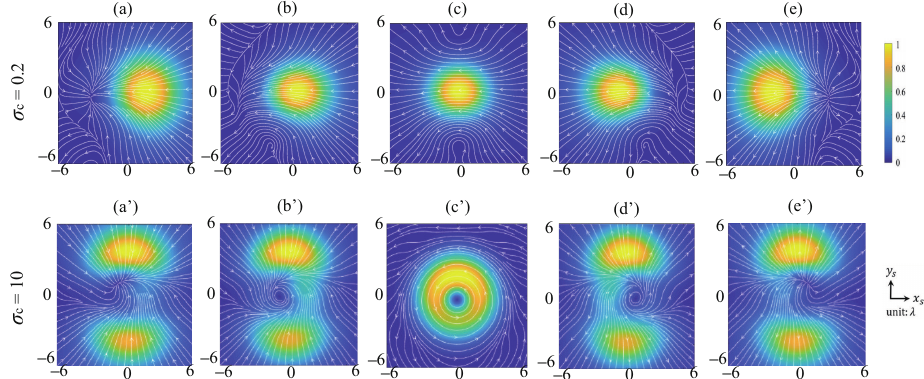
Figure 7. The transverse energy flux s xy along the propagation direction. Here, ( a , a’ ) z s = − 4 λ , ( b , b’ ) z s = − 2 λ , ( c , c’ ) z s = 0, ( d , d’ ) z s = 2 λ and ( e , e’ ) z s = 4 λ . In all plots: a = 0.5 w 0 , f = 2 mm, w 0 = 2 mm and α = 60 ◦ .